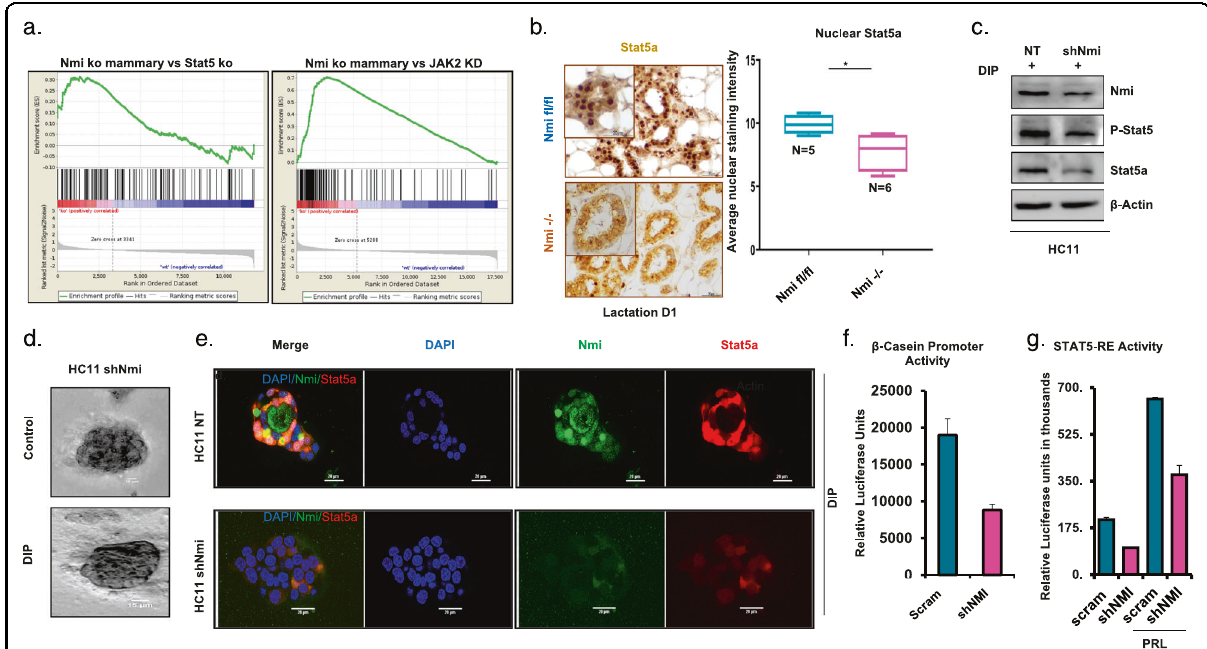
Fig. 3 Silencing NMI hindered JAK/STAT signaling mediated mammary differentiation. a GSEA of NMI wild-type compared to NMI knockout mammary mouse tissues at day 1 of lactation in comparison to list of genes upregulated after knockdown of JAK2 in HEL cells (left panel) and in comparison, to genes affected in lactating mouse mammary tissues after deletion of STAT5 enhancers (Right panel). b Immunohistochemical staining for STAT5A on mouse mammary tissues at lactation d1 in NMI fl / fl ( n = 5) vs NMI − / − ( n = 6) mice. Graph represents quanti fi ed nuclear STAT5A staining intensity, which is signi fi cantly lower in NMI − / − mice tissues ( p = 0.017). c Western blot of Nmi, P-STAT5A, STAT5A in nontransfected control vs shNMI HC11 cells. d Undifferentiated shNMI HC11 cells that were embedded in Matrigel and stimulated by DIP to differentiate shNMI cells failed to differentiate into organized mammary acini. e Immuno fl uorescent staining for NMI (Green) and STAT5A (red) in control and shNMI HC11 cells that were embedded in Matrigel and stimulated to differentiate with DIP. DAPI was used to stain the nucleus. Pictures show loss of NMI and STAT5A nuclear translocation after knocking down NMI. f Luciferase assay for measuring activity of β -casein promotor. Data show decreased activity in T47D shNMI cells ( p = 0.08). g STAT5 response element (STAT5-RE) activity was measured by a STAT5 response element reporter luciferase assay with and without prolactin. Data show diminished activity in T47D shNMI cells after prolactin